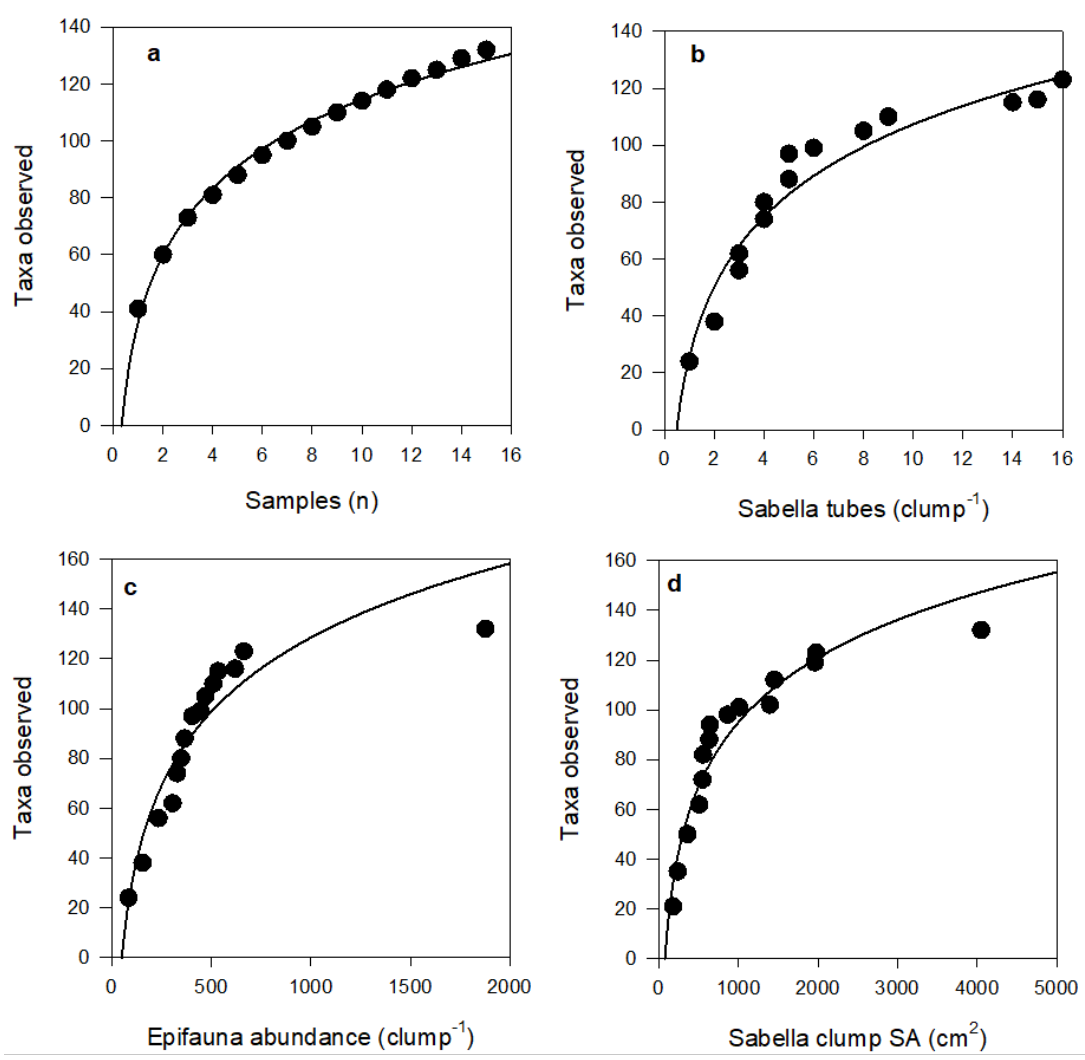
Figure 5. Species accumulation plots showing cumulative number of observed taxa with ( a ) number of Sabella clump samples (R 2 = 0.99), ( b ) number of Sabella tubes per clump (R 2 = 0.94), ( c ) epifaunal abundance per clump (R 2 = 0.88), and ( d ) Sabella clump surface area (R 2 = 0.93). Fitted curves all follow logarithmic equations, see Table S2 for further detail.